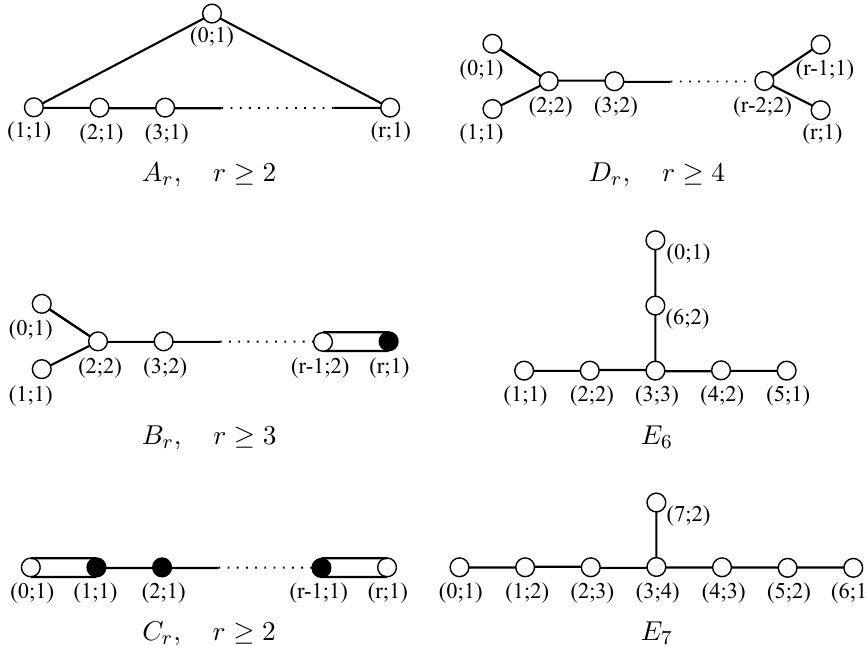
Figure 1 . The extended Dynkin diagrams and the comarks of the relevant Lie algebras. The symbol ( i ; a _ ) at each node denotes the label of the corresponding simple root and the comark. i Each black node (cid:15) corresponds to a short root, while each white node (cid:14) corresponds to a long root.